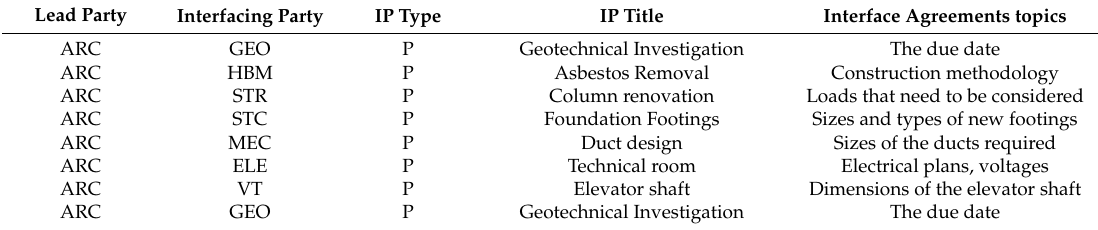
Table 3. Interface point examples related with physical adaptive reuse